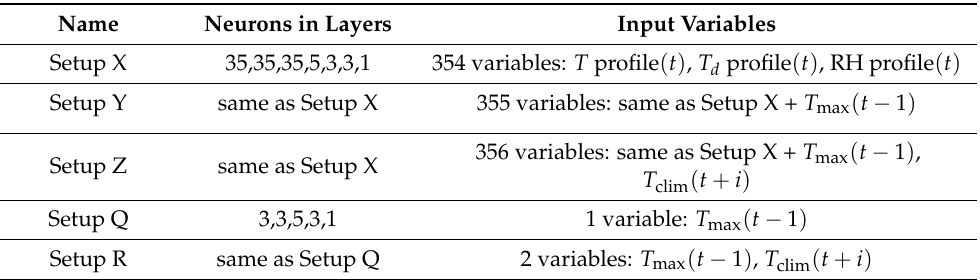
Table 3. Description of the NN setups used for the short and long-term forecasts of T max . The second column denotes the number of neurons in consecutive layers with the input layer not shown (the number of neurons in the input layer is always the same as the number of input variables). The time index t refers to the day of the radiosonde measurement, with t − 1 referring to the previous day, and t + i to the i -th day in the future. The setups for the T min forecast are identical to the setups for T max forecast with T max ( t − 1 ) replaced with T min ( t − 1 ) . In all setups Leaky ReLU was used as activation function for all layers, except for the output layer that used a linear activation